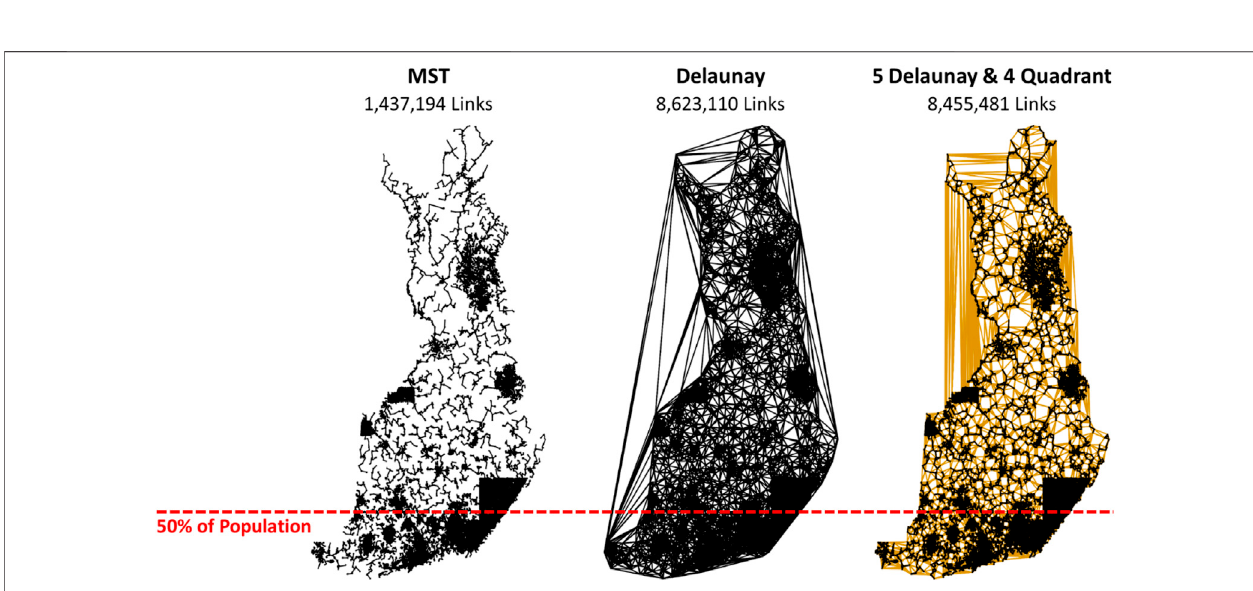
FIGURE 16 | Different graphs and the corresponding number of links. Most people in Finland live in the South, where data are denser than those in the North.